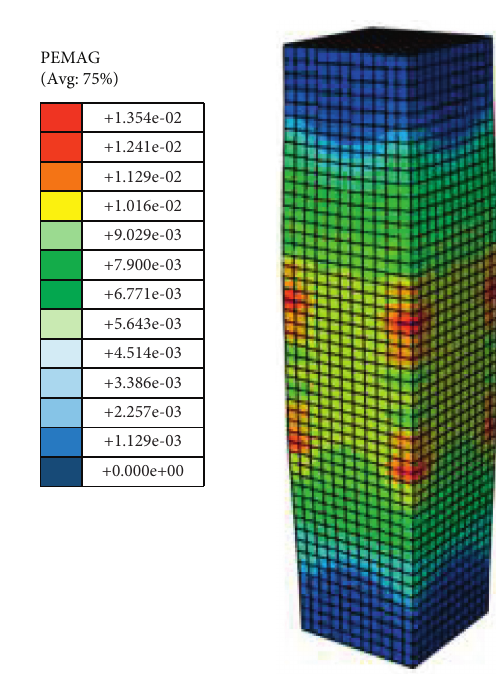
Figure 9: Stress nephogram of angle